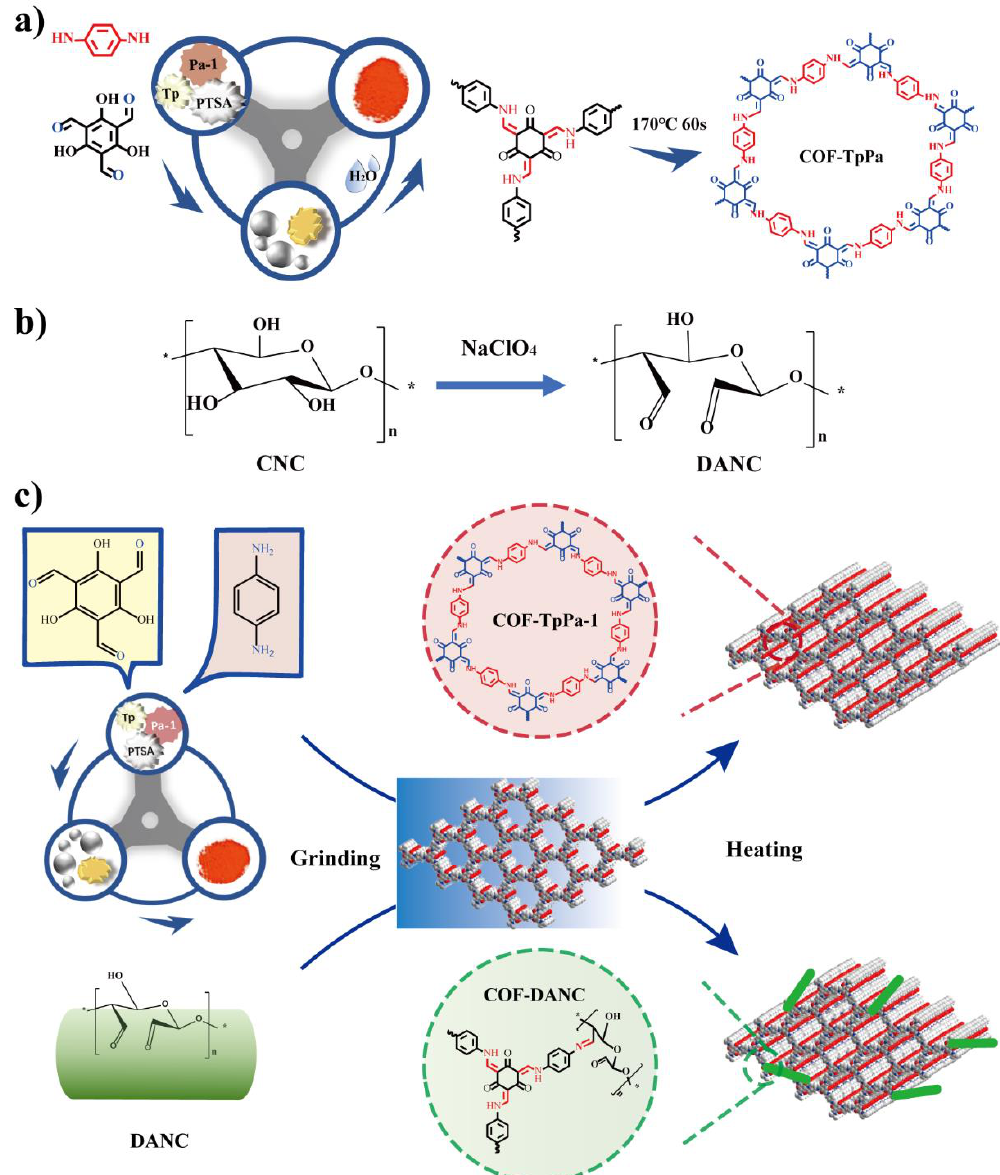
Figure 1. ( a ) Preparation of covalent organic framework COF-TpPa-1 by grinding method; ( b ) Preparation of 2,3-dialdehyde nanocrystalline cellulose (DANC) by sodium periodate method; ( c ) Preparation process of TpPa-1-DANC composite.